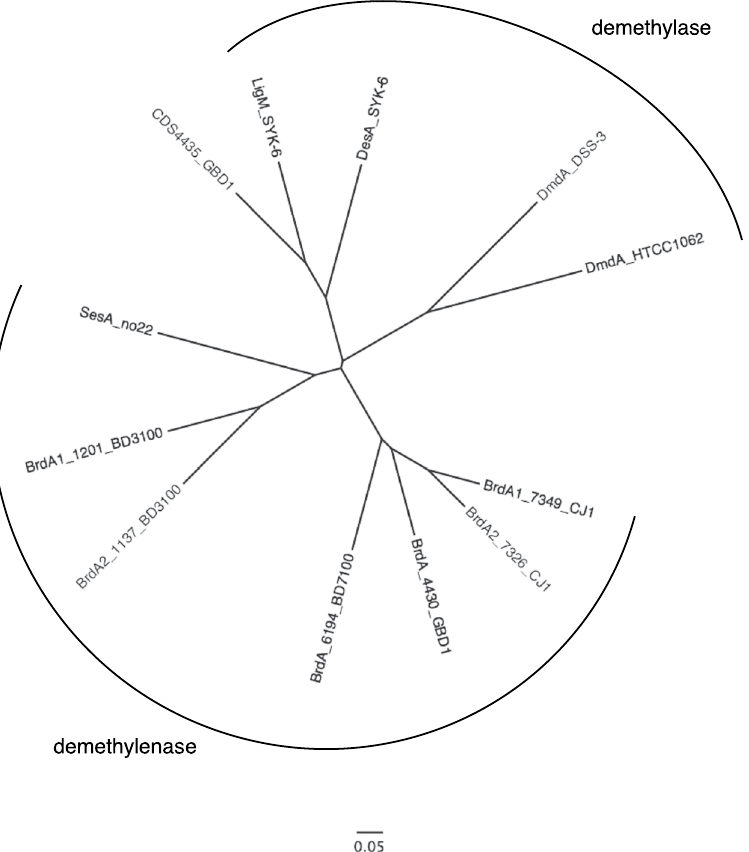
Figure 3. Phylogenetic tree of amino acid sequences in THF-dependent demethylenases and demethylases. The multiple alignments were generated by ClustalW, and phylogenetic trees were constructed using the neighbor-joining method. The amino acid sequences were obtained from NCBI. Enzymes: DmdA_DSS3, DMSP demethylase of Ruegeria pomeroyi strain DSS3 (accession: AAV95190); DmdA_HTCC1062, DMSP demethylase of Candidatus Pelagibacter ubique strain HTCC1062 (AAZ21068); DesA, syringate demethylase of S. paucimobilis SYK-6 (BAC79257); LigM, vanillate demethylase of SYK-6 (BAD61059); and SesA, sesamin demethylenase of Sinomonas sp. no. 22 (LC101493). The scale corresponds to a genetic distance of 0.05 substitutions per